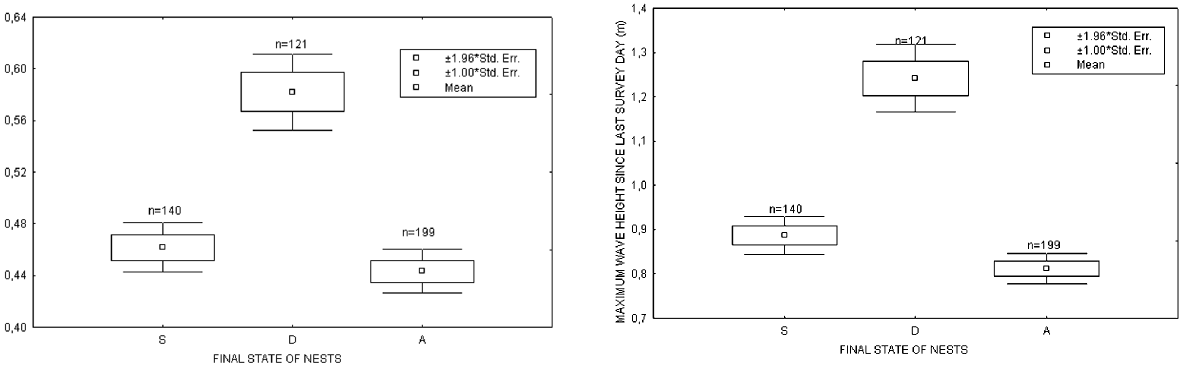
Fig. 4. – Plot of means and standard errors of maximum values of significant wave height occurring since the last survey day for the total number of nests reaching any of the final states (S=successful nests; D=destroyed nest; A=abandoned nests; n=total number of nests).